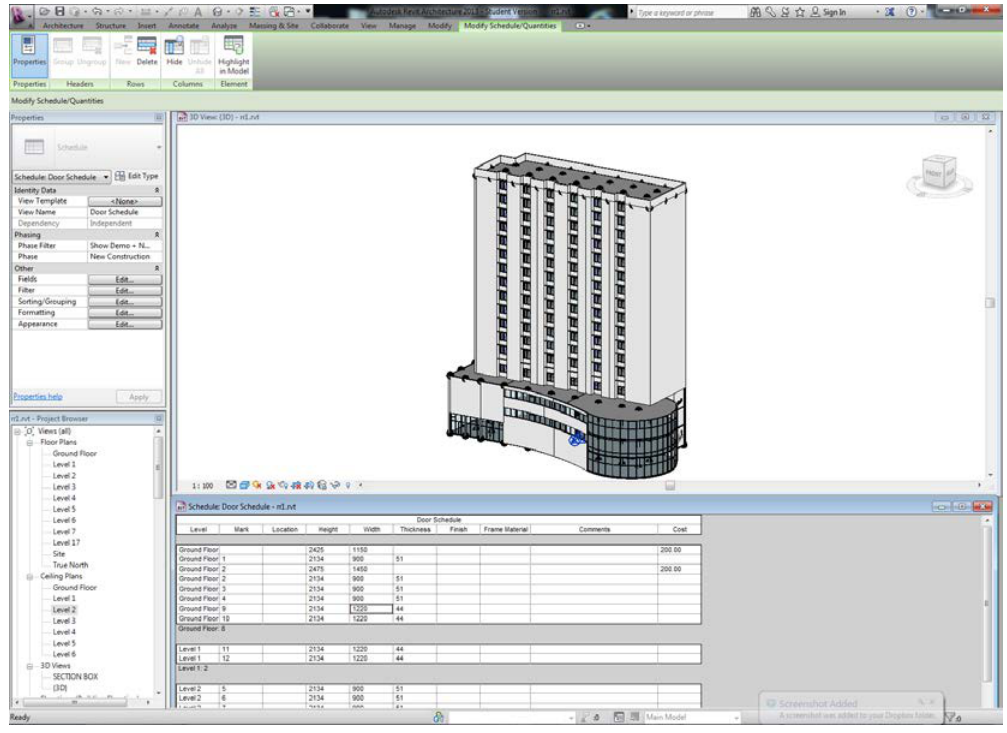
Figure 2: IFCs and model element